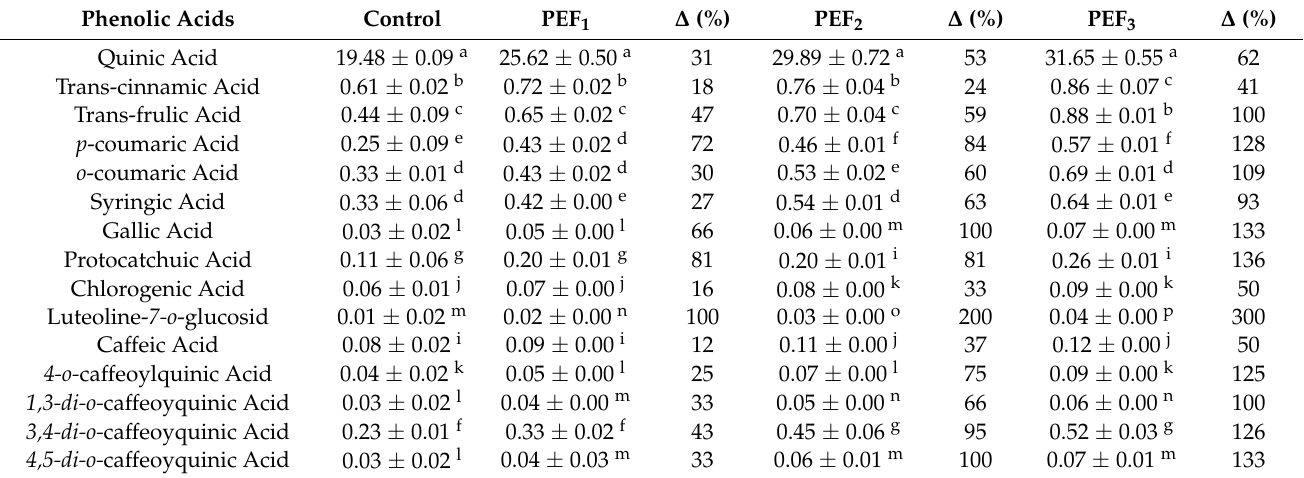
Table 1. Concentrations of phenolic compounds (mg GAE.100 g − 1 FW) of date fruits.